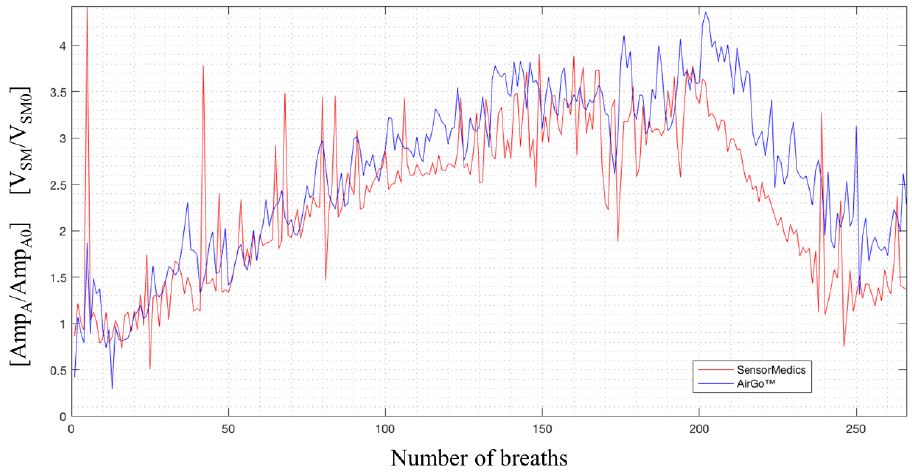
Figure 8. SensorMedics’ normalized volumes (in red) and Airgo ™ ’s normalized amplitudes (in blue) synchronized, exercise test, healthy male subject (45 years old, 169 cm, 62 kg).